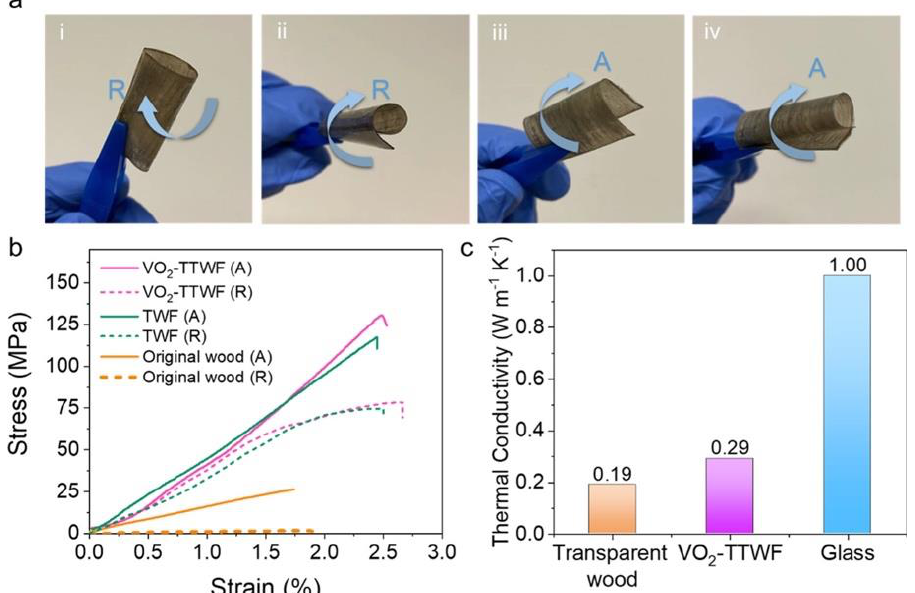
Figure 18. ( a ) VO 2 -TTWF was folded and rolled in both A (axial) and R (radial) directions, as shown in the images i–iv. ( b ) Stress–strain curves of VO 2 -TTWF, TWF, and original wood in A and R directions. ( c ) Comparison of thermal conductivity of VO 2 -TTWF, transparent wood, and glass. Reprinted with permission from [39], copyright 2021, American Chemical Society.